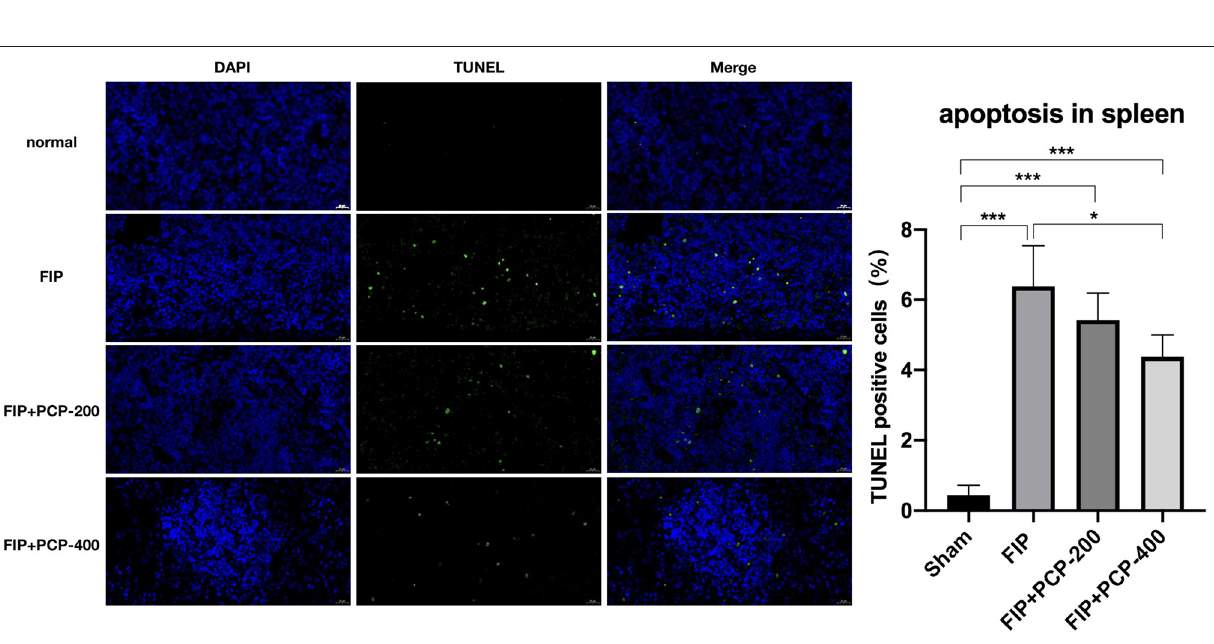
FIGURE 8 | The impact of PCP on vital signs in the fecal peritonitis-induced septic spleen. PCP pretreatment contributed to decreased percentage of TUNEL-positive cells, * P < 0.05; *** P < 0.001, FIP + PCP-200 = FIP with PCP 200 mg/kg; FIP + PCP-400 = FIP with PCP 400 mg/kg. All presented data are a composite of three independent experiments. n = 5 in each